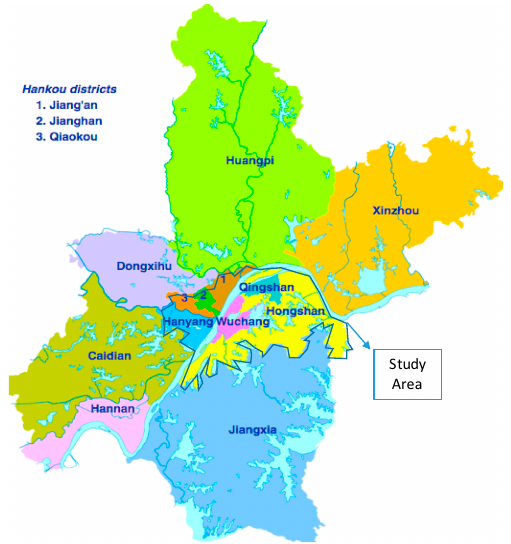
Figure 1. Map of Wuhan City, with the study area (central districts) indicated in blue.